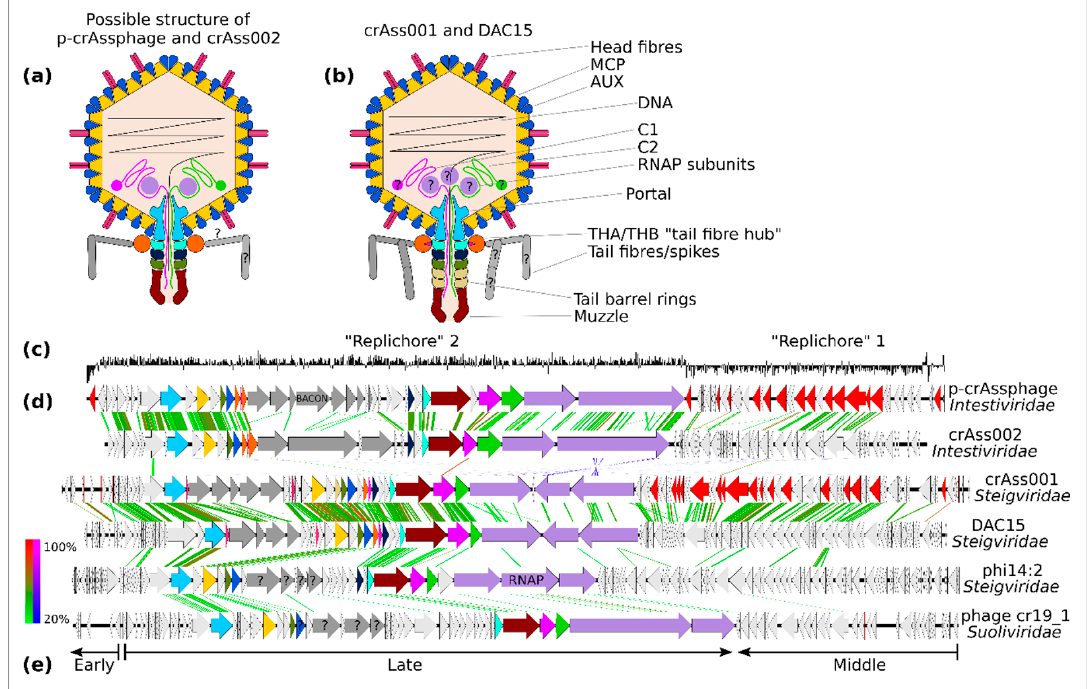
Figure 2. Virion and genome structure of the typical representatives of the order Crassvirales . A schematic structure of Intestiviridae virions ( a ) is extrapolated from the cryoEM structural data available for Steigviridae ( b ). Colours of the protein subunits ( a , b ) are consistent with ORF colouring ( d ). GC-skew graph of the p-crAssphage genomes shows clear separation into two possible replichores ( c ). Despite significant divergence in the amino acid sequence of the encoded proteins, all families show clear genome collinearity ( d ). Three transcriptional modules can be identified: early (regulatory), middle (DNA replication), and late (structural proteins and other virion components), as exemplified by a Suoliviridae genome ( e ).